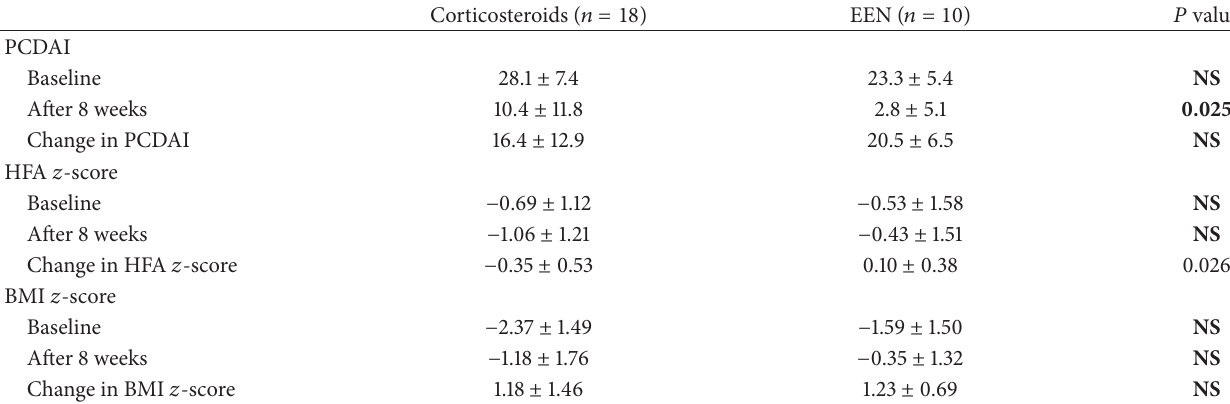
Table 2: Comparison of PCDAI, nutritional status, and growth